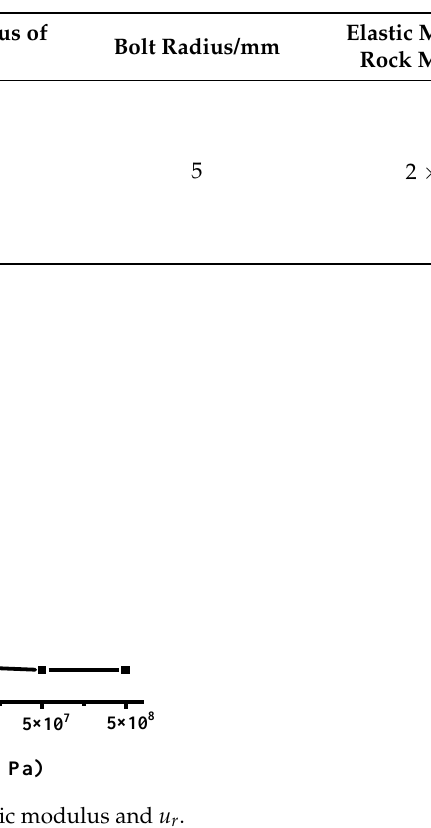
Table 2. Bolt number and elastic model parameters.